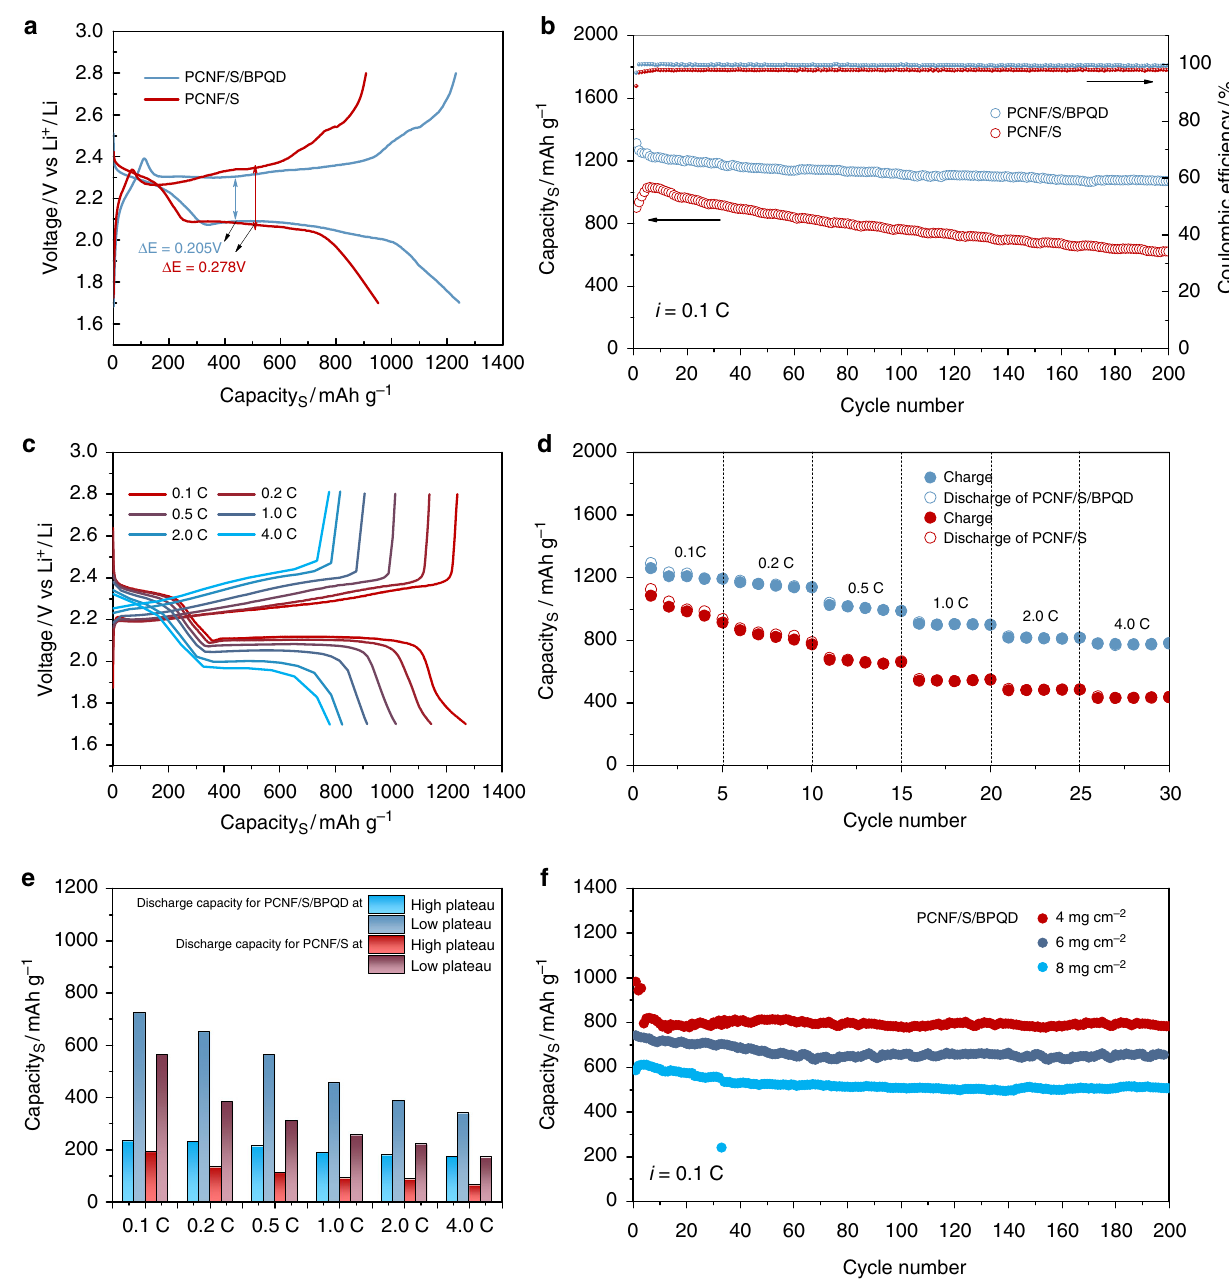
Fig. 5 Electrochemical performance of cathodes. a Initial discharge – charge pro fi les at 0.1 C between 1.7 and 2.8 V vs. Li + /Li, b cyclic capacities and Coulombic ef fi ciencies at 0.1 C for 200 cycles, c discharge – charge voltage pro fi les of the porous carbon nano fi ber/sulfur/black phosphorus quantum dot (PCNF/S/BPQD) cathode at different rates, d cyclic capacities at different rates, e high plateau and low plateau discharge capacities derived from rate performance, f cyclic performance of the PCNF/S/BPQD at 0.1 C for 200 cycles with increasing sulfur loadings of 4, 6, and 8 mg cm − Coulombic ef fi ciencies during cycles ( ≈ 98% for PCNF/S vs. ≈ 99.9% for PCNF/S/BPQD, respectively). The two electrodes